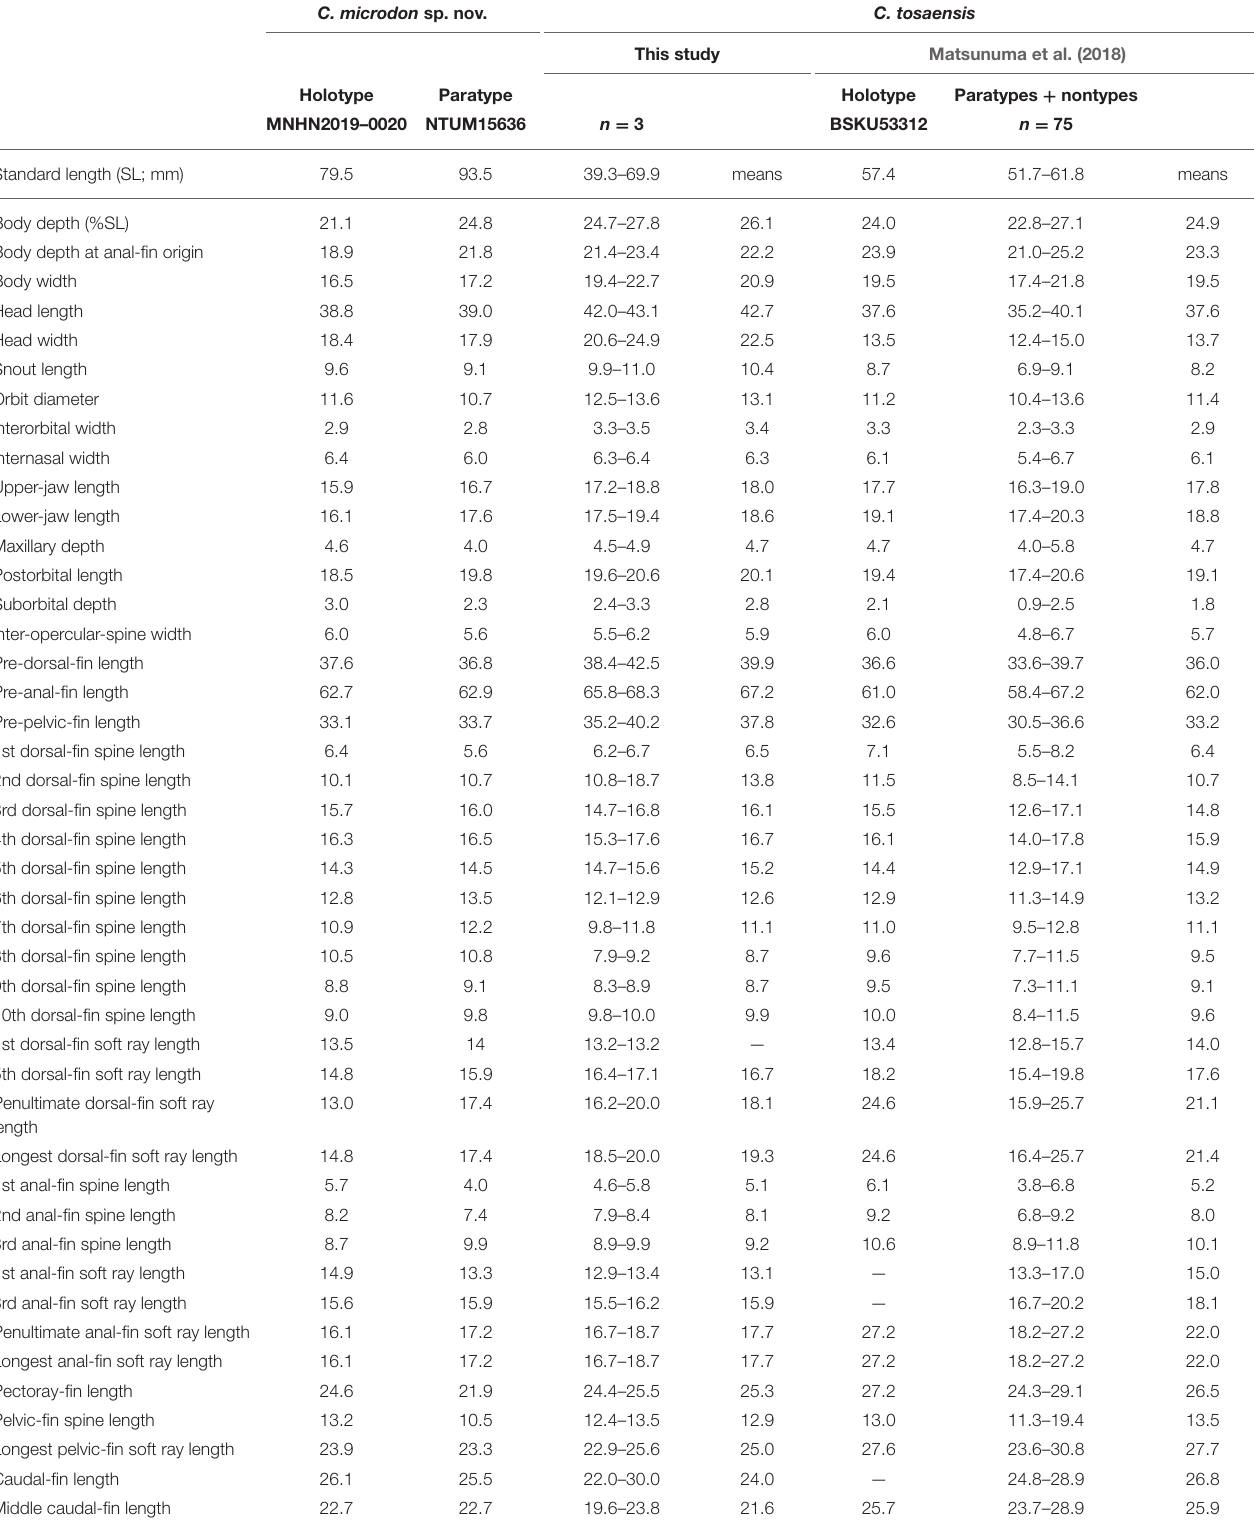
TABLE 6 | Mophometrics expressed as percentages of the standard length for Chelidoperca microdon sp. nov and C. tosaensis (including examined specimens and reference